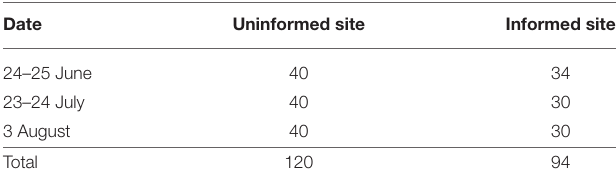
TABLE 1 | Amount of water (mm) applied to the uninformed and informed sites during the study period. Uninformed site Informed